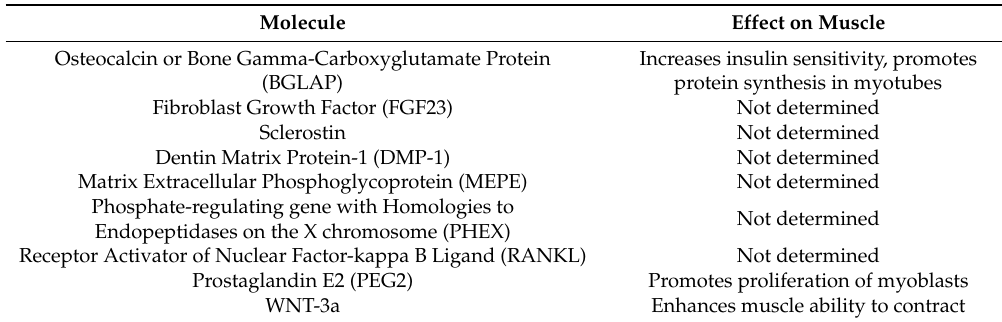
Table 2. Osteokines and the effects on muscle that are